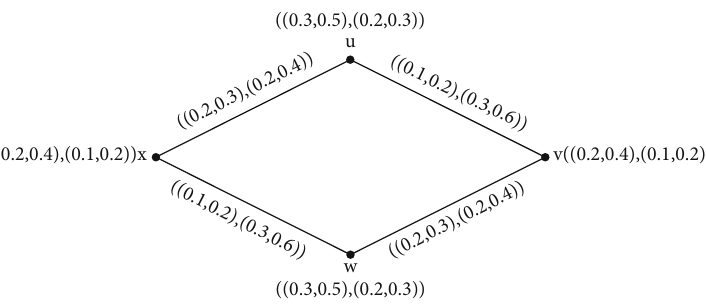
Figure 1: G is both NEI-IVIFG and